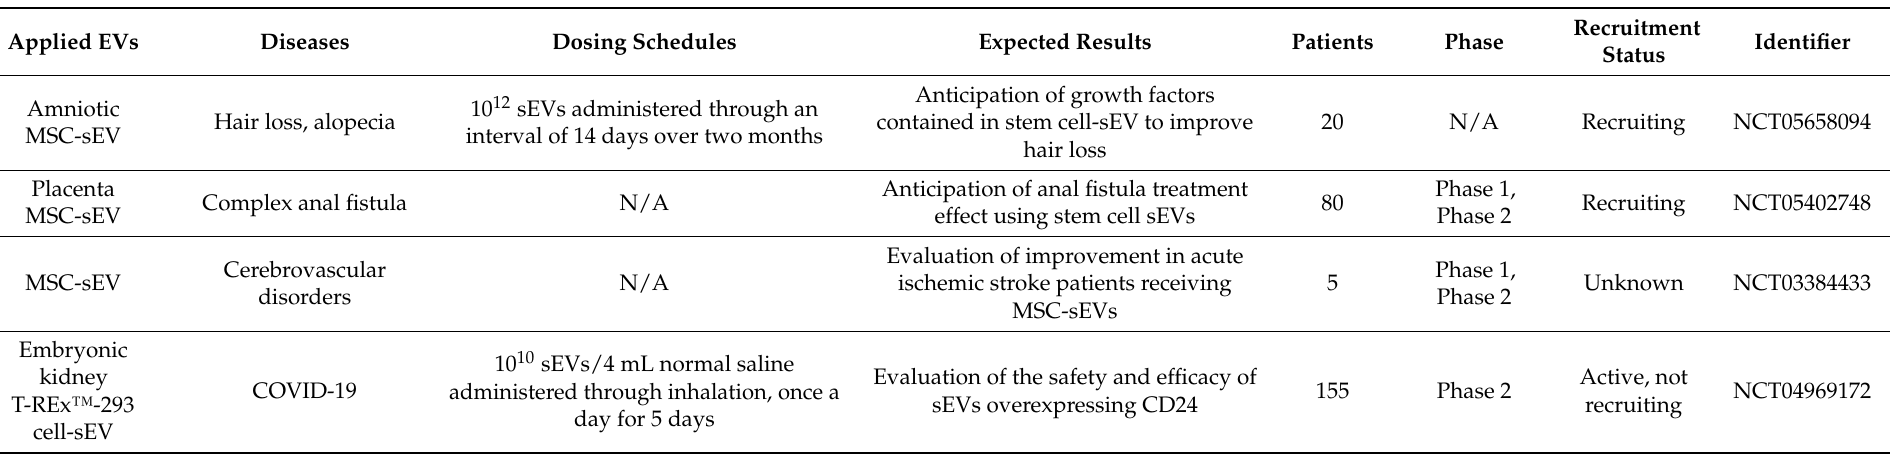
Table 5. sEV therapeutics in clinical